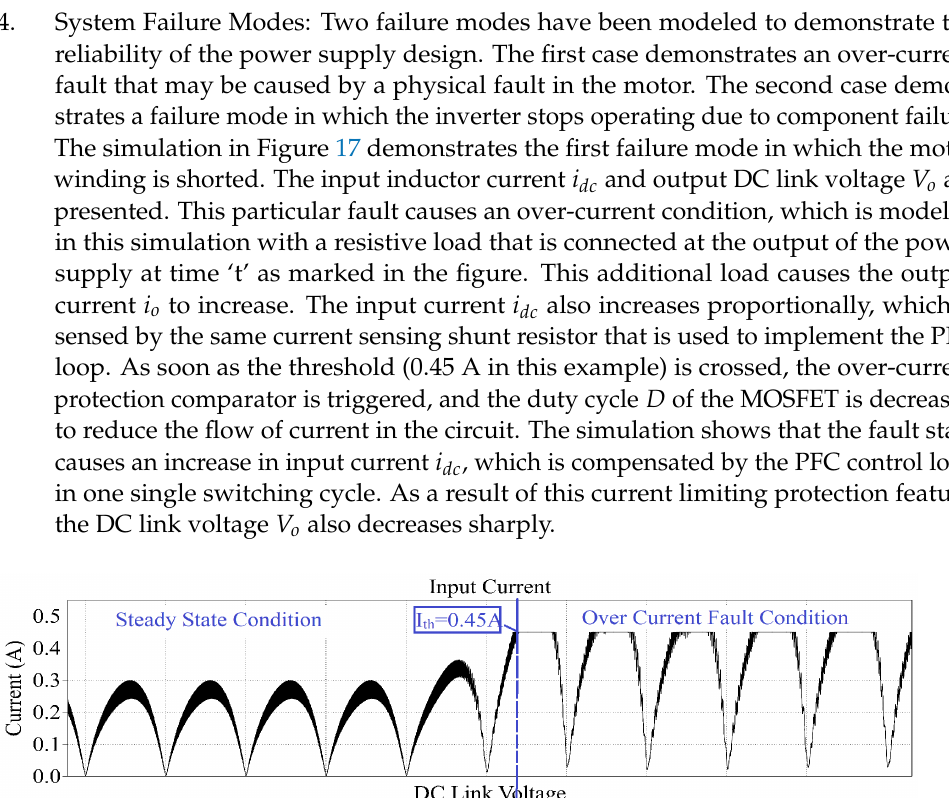
Figure 16. Frequency domain simulation depicting the high frequency components of the stator currents i abc and motor torque T e .